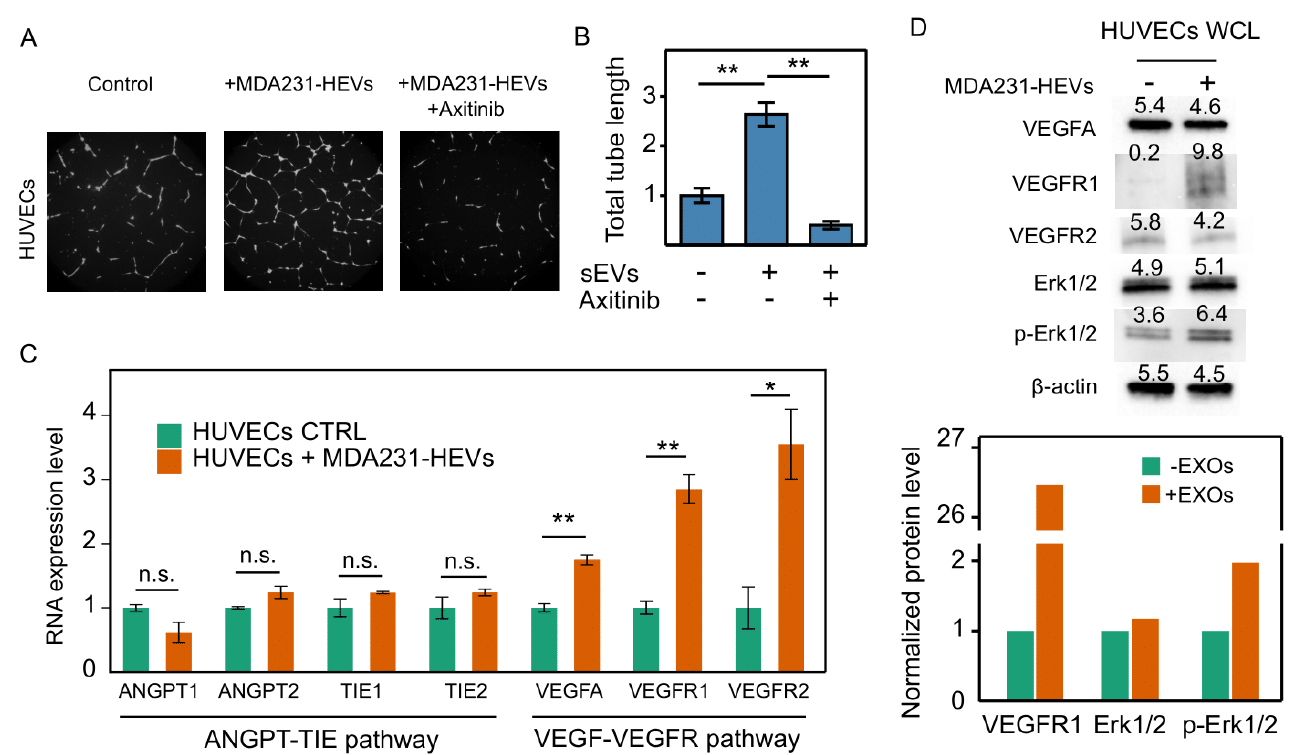
Figure 5. Downstream effects of cancer EVs on angiogenesis. ( A ) Tube formation assay of HUVECs incubated in basal medium (control), treated with 50 µg/mL MDA231-HEVs, or treated with both MDA231-HEVs and 0.1 µM Axitinib (inhibitor of VEGFR) for 24 h. The EVs induced formation of denser tube networks, which can be efficaciously blocked by Axitinib. Images are representative of two independent experiments. ( B ) The total tube length of images from the same experiment were analyzed by ImageJ and normalized by the average of the control group ( N = 6). ( C ) MDA231-HEVs upregulated the VEGF-VEGFR angiogenesis pathway related gene, while showing no effect on the other ANGPT-TIE angiogenesis pathway in HUVECs ( N = 3). ( D ) Western blot of proteins involved in the VEGF-VEGFR angiogenesis pathway. MDA231-HEVs conspicuously enhanced the level of VEGFR1 and the phosphorylation of downstream Erk1/2. Average intensities of the bands were first normalized to β -actin, and then normalized to the control group. Images are representative of two independent experiments. n.s.: not significant, * P < 0.05, ** P < 0.01 based on Mann–Whitney U test for ( B ), or Student’s t test for ( C ). Error bars stand for SEM for ( B , C ).